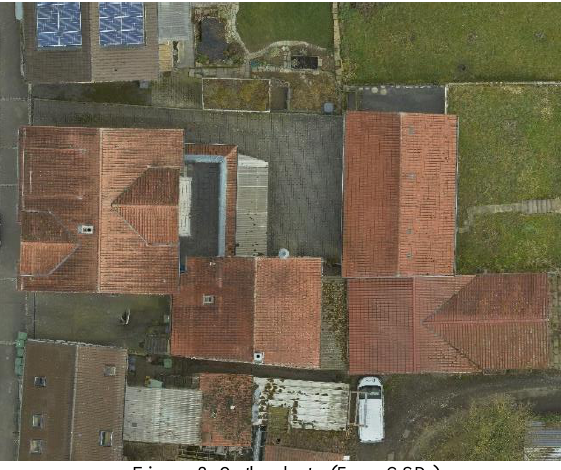
Figure 8. Orthophoto (5 cm